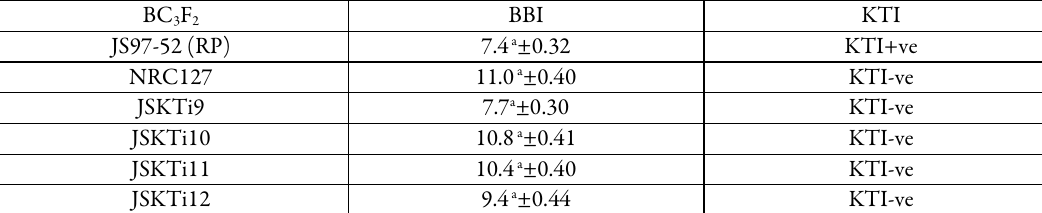
Table 2. BBI concentration (mg/g defatted soy flour) in KTI-free BC 3 F 2 lines BC 3 F 2